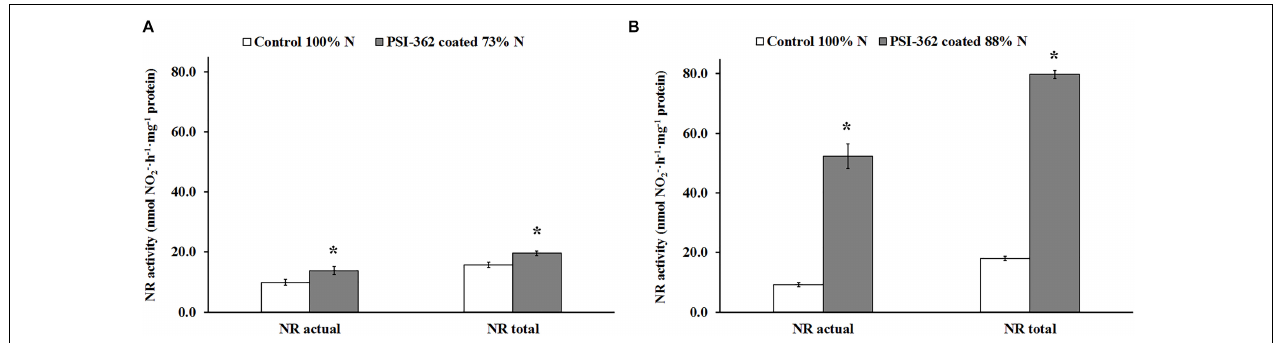
FIGURE 5 | NR activity in spring barley shoot tissue (cv. Gangway). The effect of PSI-362 coated CAN + S fertilizer on actual NR (in presence of MgCl 2 ) and total NR (in absence of MgCl 2 ) activity was evaluated in shoot tissue 22 days after application. (A) Barley crop grown in the field 1 under 73% N recommended fertilizer rate; (B) barley crop grown in the field 2 under 88% N recommended fertilizer rate. Results in treated plants were benchmarked against untreated plants growing under 100% N fertilizer rate. Means followed by asterisk within the same NR activity type and field indicate significant differences between control and the PSI-362 treatment based on t -test at p ≤ 0.05. Number of biological replicates ( n ≥ 4).